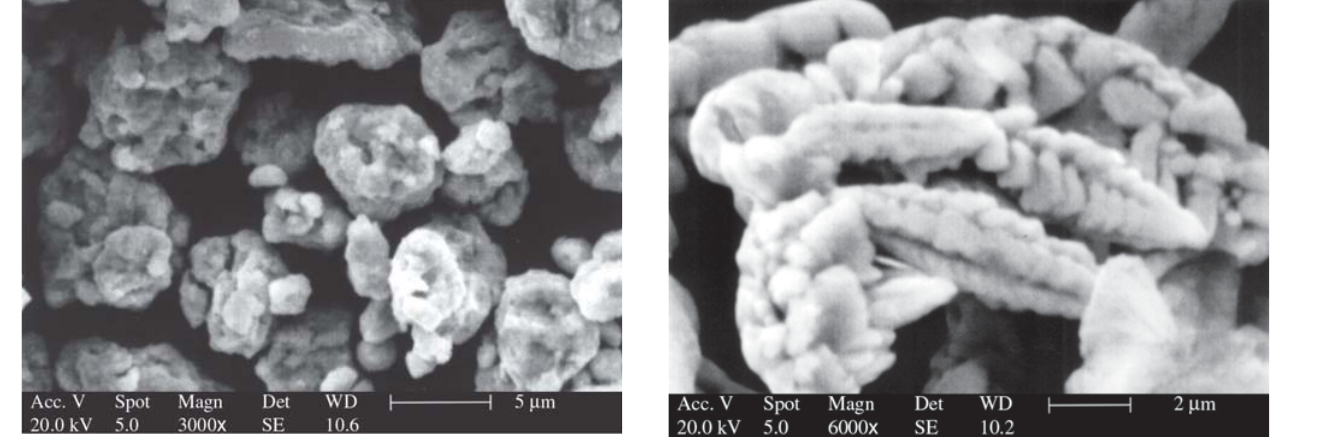
Figure 6. Scanning electron micrograph of Cu-13Al-2Nb milled for 5 hours without a lubricant.